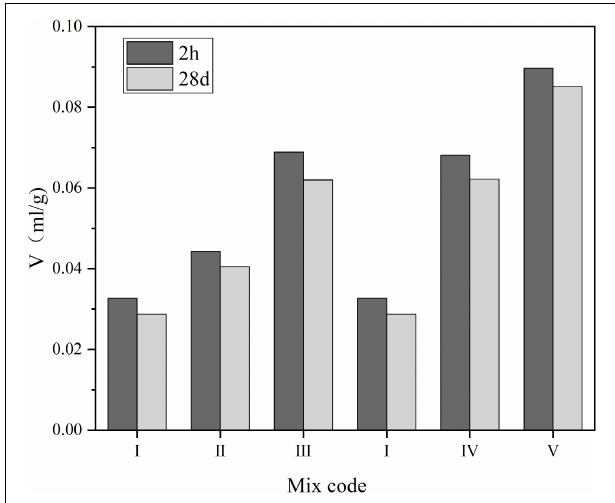
FIGURE 8 | Pore cumulative volume of the CAEM at the age of 2 h and 28 days.